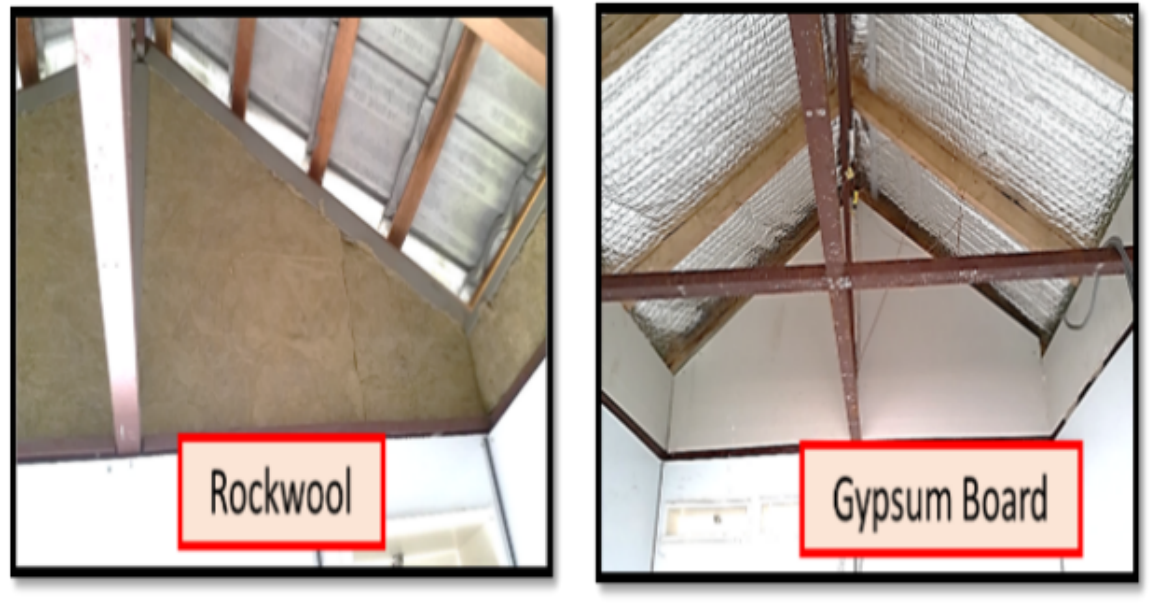
Figure 7: Wall insulation material